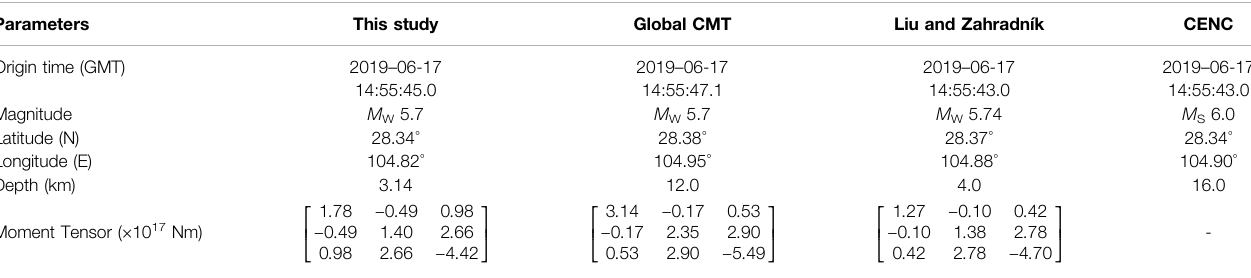
TABLE 1 | The source parameters of Changning earthquake from different af fi liations. Parameters This